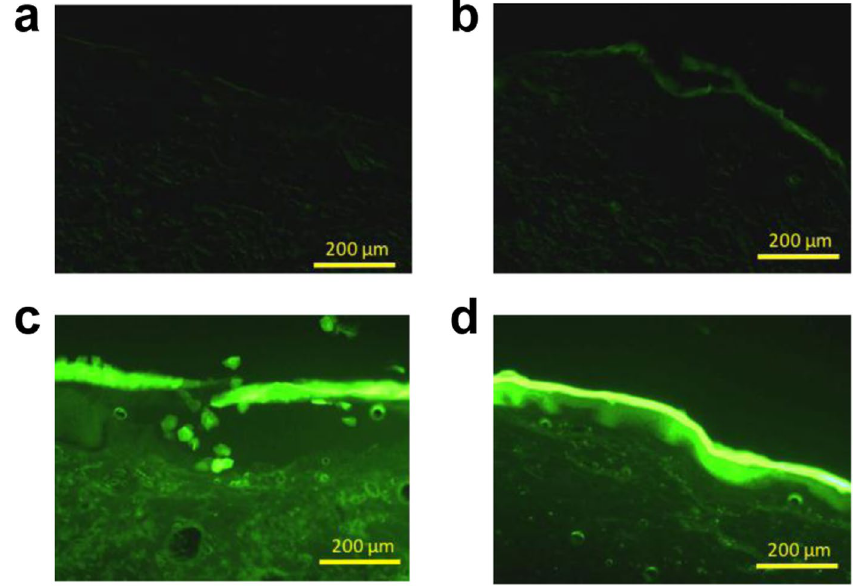
Figure 6. Representative confocal images of skin treated with TG-NOB in ( a ) PBS, ( b ) PBS: DGME, ( c ) PBS: EtOH, and ( d ) CAGE. Each sample was added to the donor of a FDC and incubated for 24 h at 37 °C. After incubation, the skin was soaked in OTC compound in Tissue-Tek ® Cryomold ® and frozen at − 70 °C. The frozen skin samples were sliced to a thickness of 20 μ m and then imaged on a fluorescence microscope.